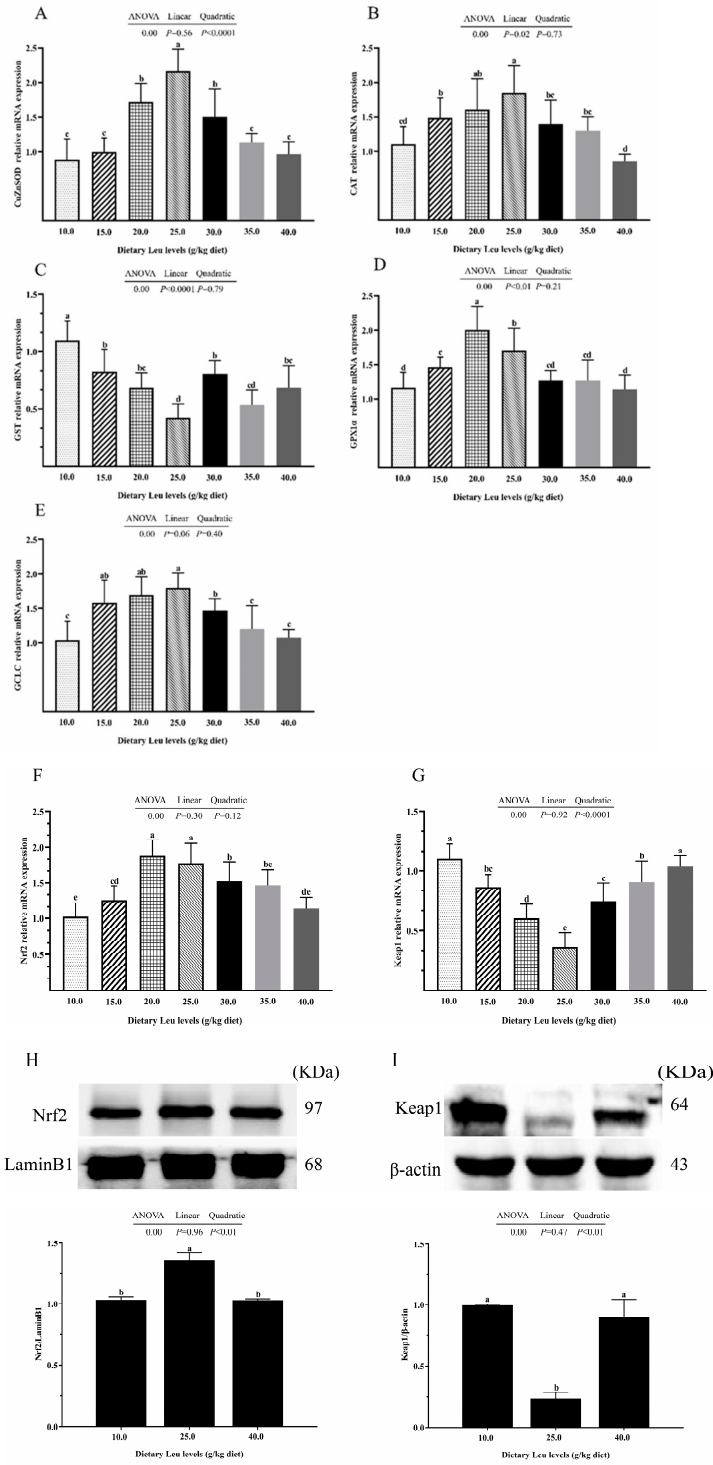
Figure 2. Effect of dietary Leu on the antioxidant capacity in intestine of hybrid catfish fed diets with graded levels of Leu (g/kg) for 56 days. ( A – G ) The mRNA expressions of CuZnSOD, CAT, GST, GPX1 α , GCLC, Nrf2, and Keap1. ( H , I ) The protein levels of Nrf2 and Keap1. Values are means ± SEM (n = 3 × 6), with six fish in each replicate. Duncan’s multiple range test used to detect significance. Different superscripts above the bars indicate significant differences ( p < 0.05).